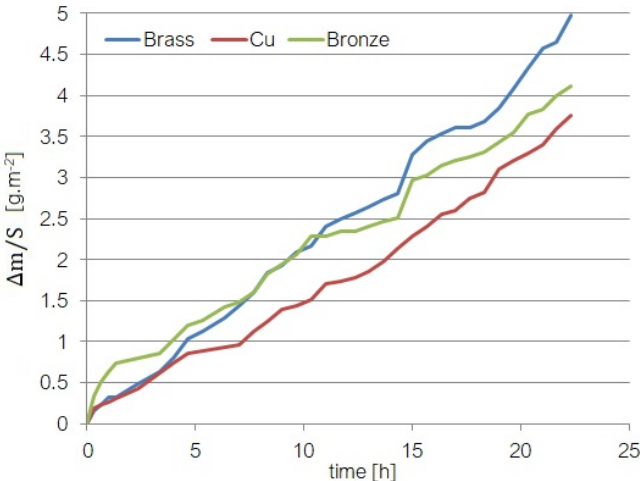
Figure 2. Data series.